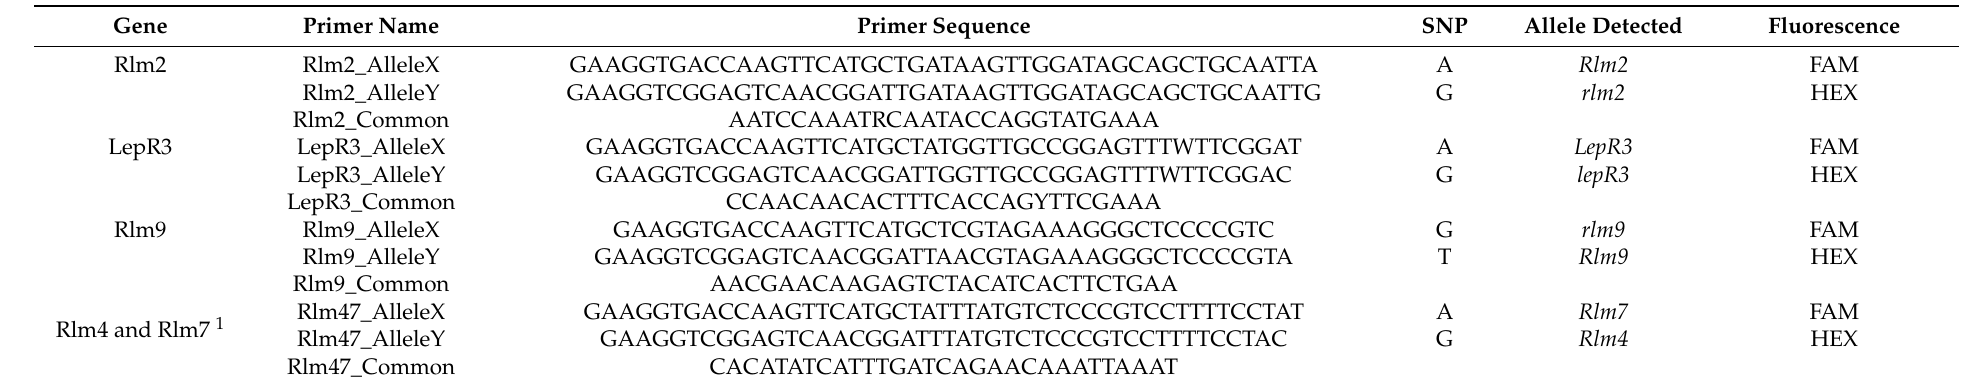
Table 2. Primer sequences for Kompetitive Allele-Specific PCR (KASP) markers for the Brassica napus resistance genes Rlm2 , LepR3 , Rlm9 , Rlm4 and Rlm7